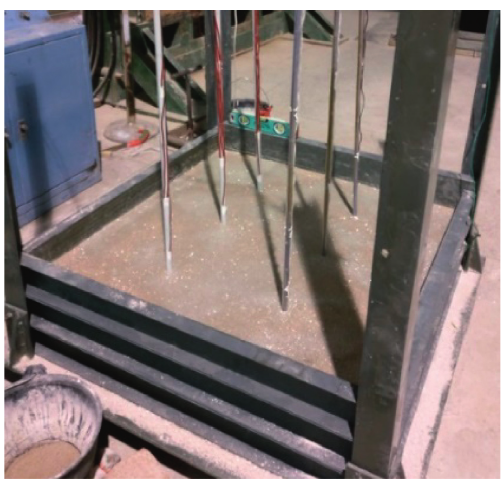
Figure 5: The three-dimensional physical simulation model.